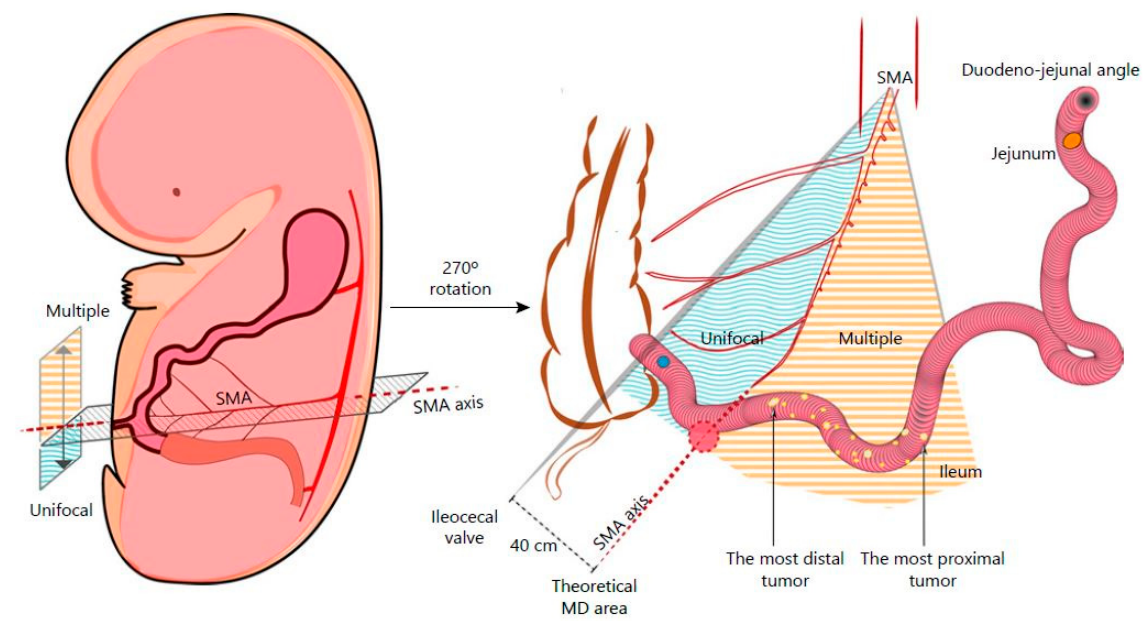
Figure 1. Embryological theory of single or multiple tumors. Figure issued from Kalifi, M., Walter, T., Milot, L., et al.: Unifocal versus Multiple Ileal Neuroendocrine Tumors Location: An Embryological Origin. Neuroendocrinology 2021; 111: 786–793. DOI: 10.1159/000511849. Reproduced with permission of S. Karger AG [10].